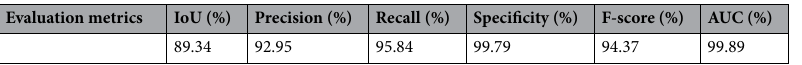
Table 2. Performance of the U-Net for segmentation of fecal matter in meat surface images.